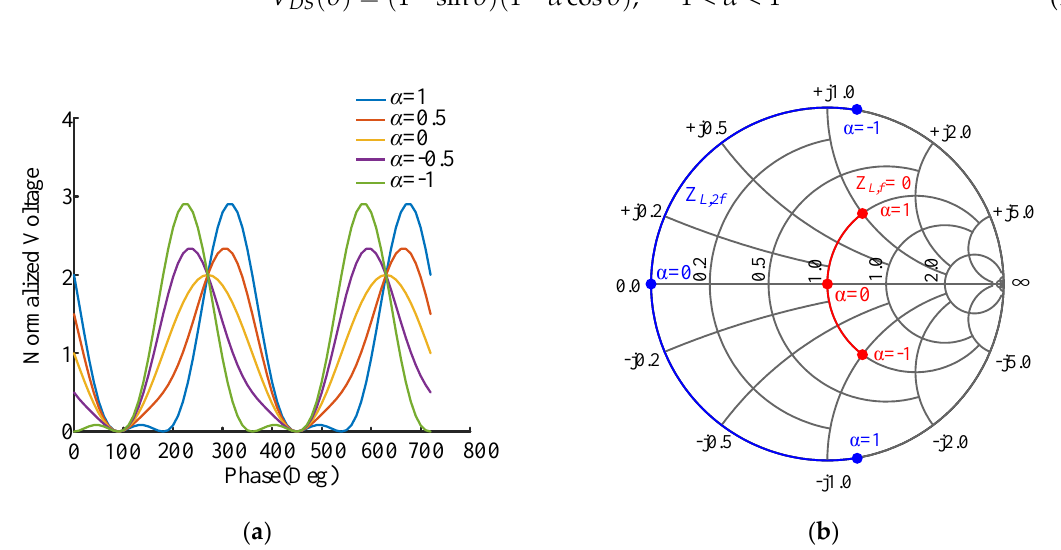
Figure 1. ( a ) The normalized voltage waveforms of continuous class B power amplifiers (PAs) from α = − - to α = 1. ( b ) The desired fundamental and harmonic load impedances at the current source node of the field-effect transistor (FET) in continuous class B mode.